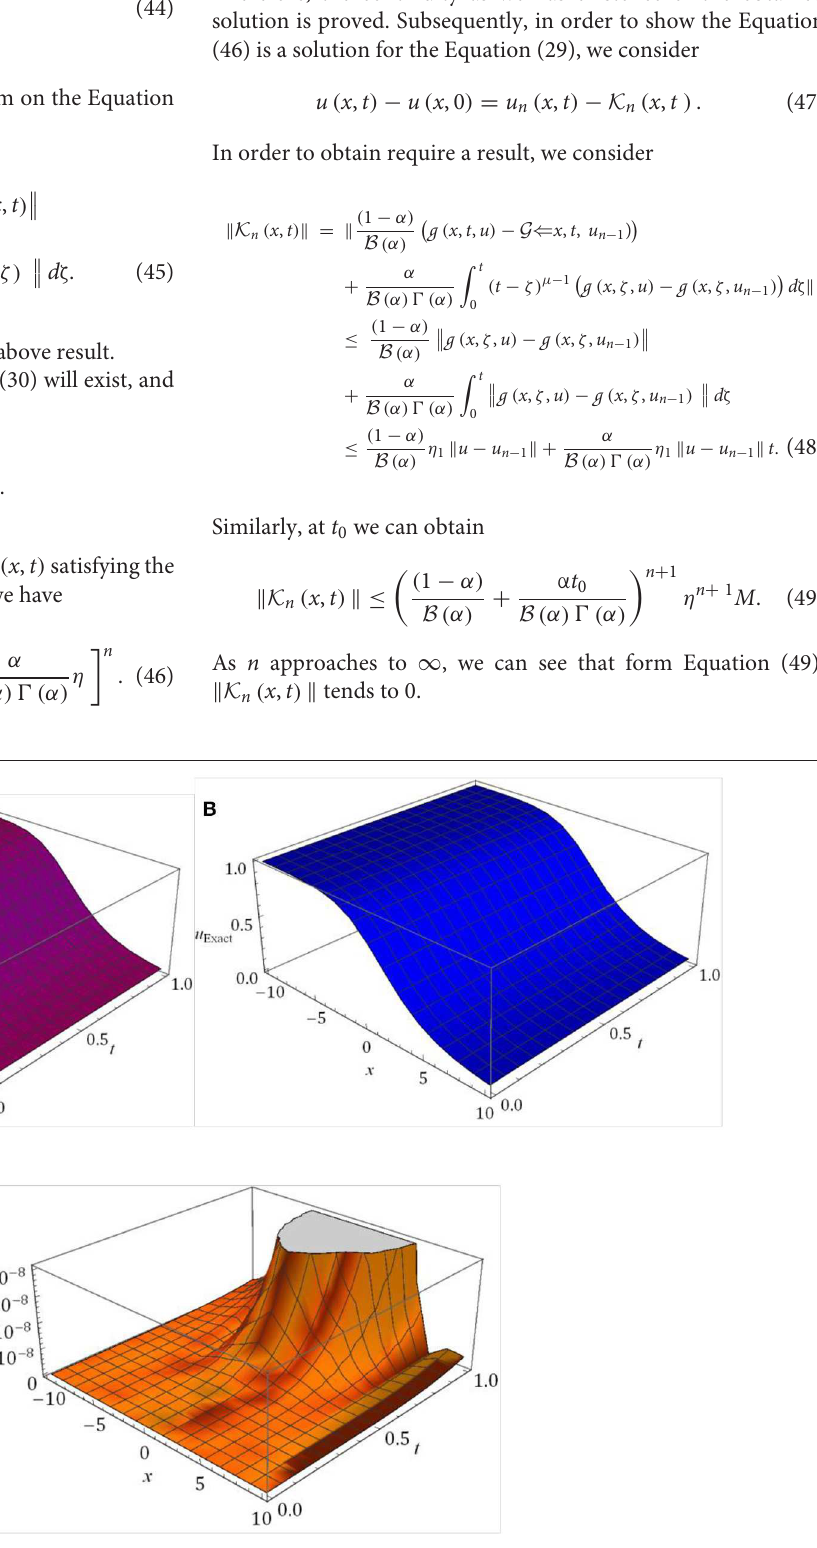
u Exact − u q − HATM for FR equation considered in Case 1 at ℏ = − 1, n = 1 and α = (cid:12) (cid:12) (cid:12) (cid:12)